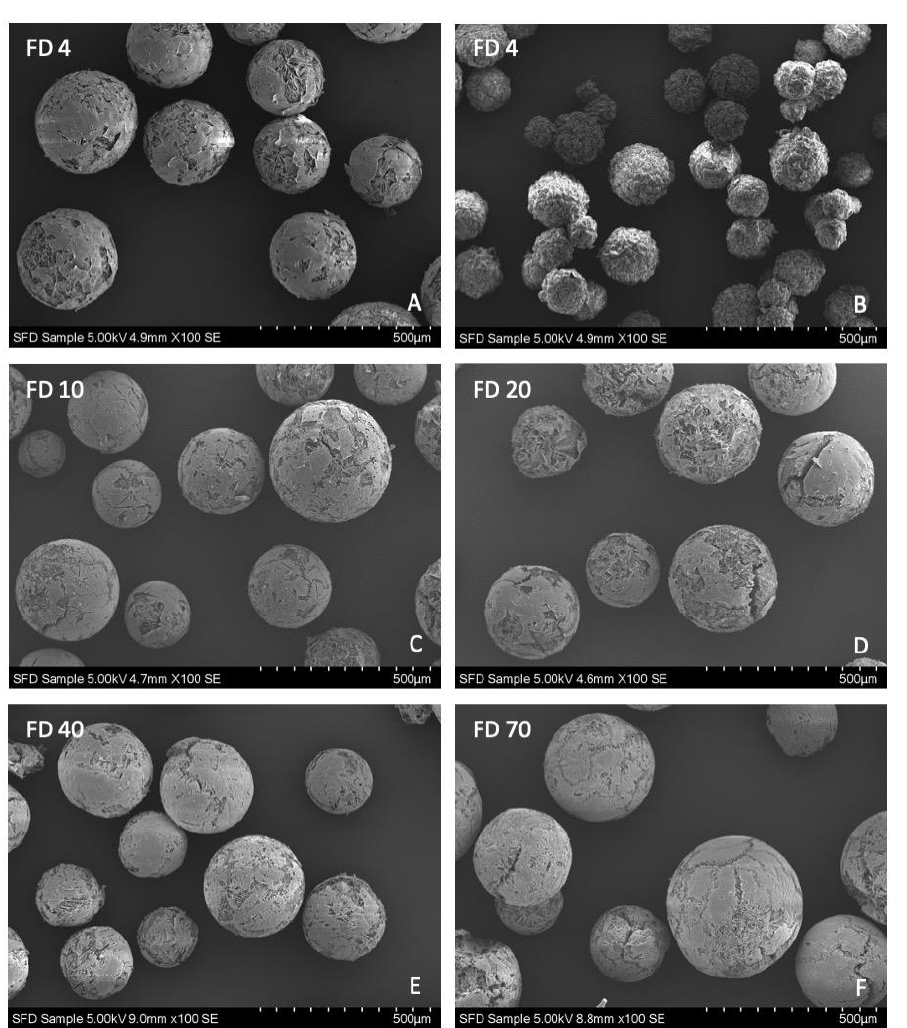
Figure 3. SEM images of FITC-dextran loaded SFD particles showing FD 4 without penetration enhancer ( A ), FD 4, FD 10, FD 20, FD 40, and FD 70 with sodium taurocholate ( B – F ). Table 1. Particle size distribution of insulin or FITC-dextrans loaded SFD particles.